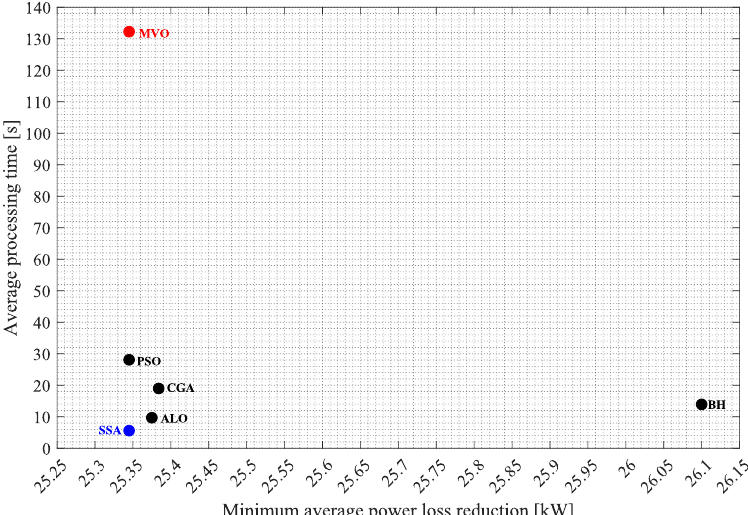
Figure 11. Trade-off provided by the solution methodologies between average minimum power losses and required processing time in the 69-node system.